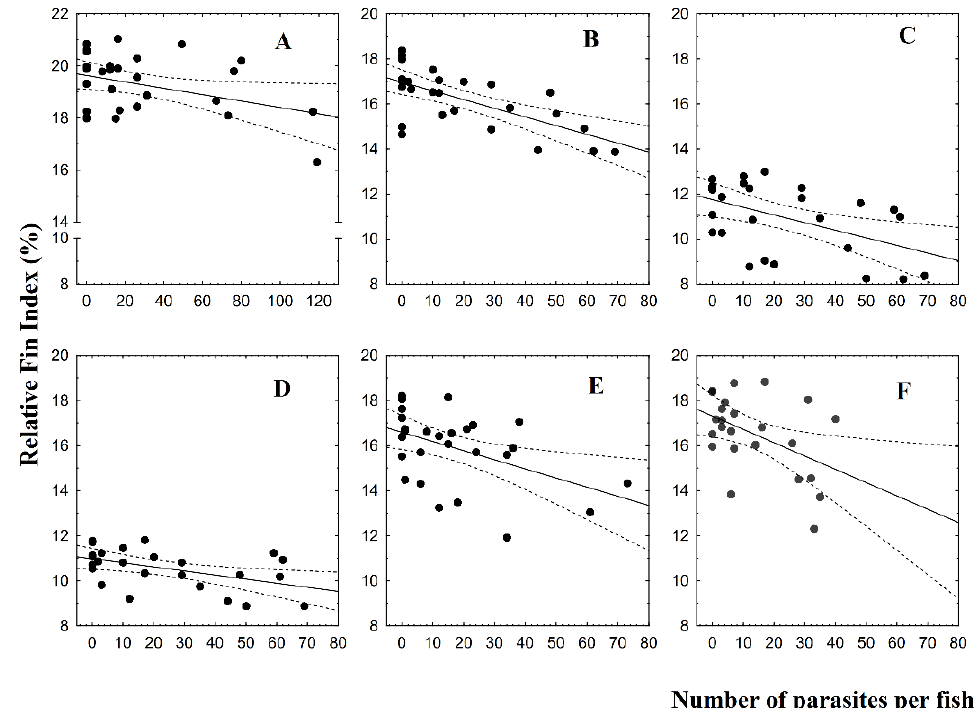
Figure 3. Linear relationships between the mean relative fin index (%) and Caligus rogercresseyi abundances of Atlantic salmon ( Salmo salar ) for ( A ) caudal fin at 1 dpi, ( B ) pectoral, ( C ) pelvic, ( D ) anal fin at 8 dpi, and pectoral fin ( E ) at 16 dpi, and ( F ) at 22 dpi.